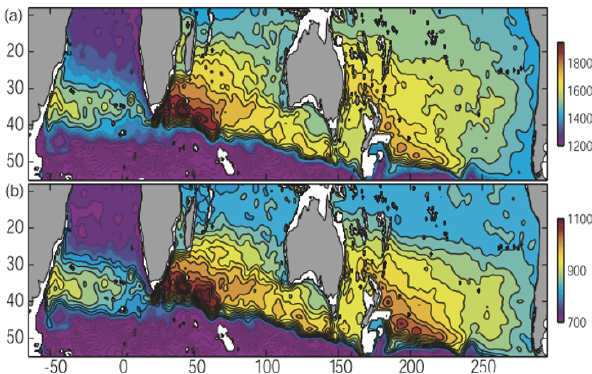
Figure 16. The interbasin supergyre system for the Pacific Ocean and Indian Ocean as shown by the depth-integrated steric heights (a) P 0 / 2000 and (b) P 400 / 2000 derived from the CARS climatolog- ical temperature and salinity fields. The contour interval in (a) is 50m 2 , and it is 25m 2 in (b) . Taken from Ridgway and Dunn